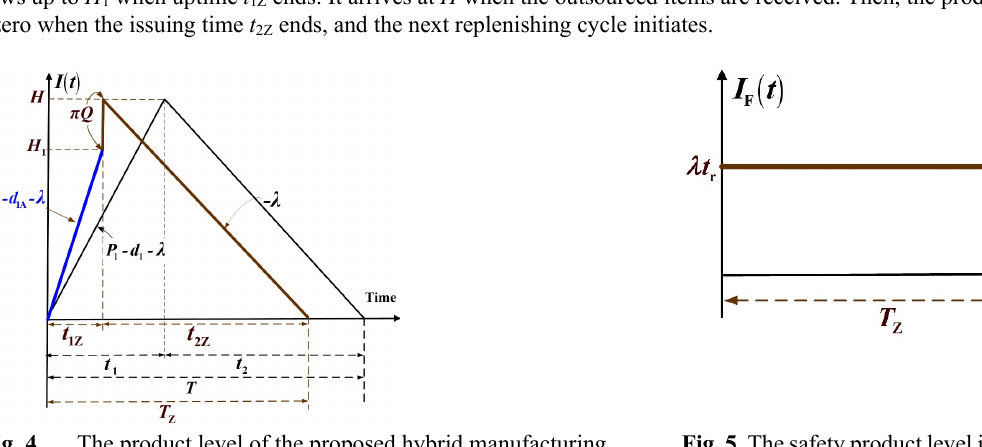
Fig. 5. The safety product level in condition